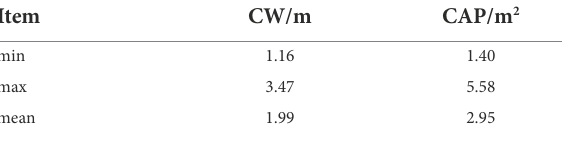
TABLE 1 Statistics of crown width and crown projection